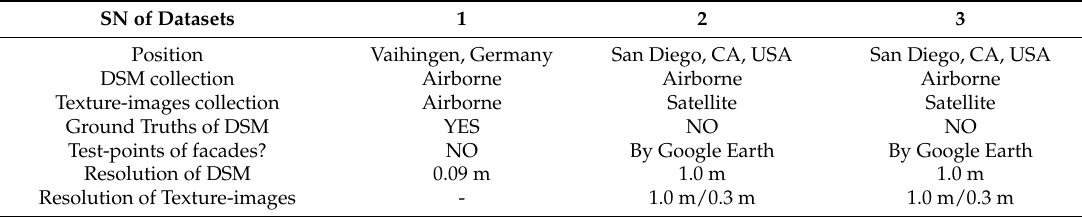
Table 1. Statement of datasets.